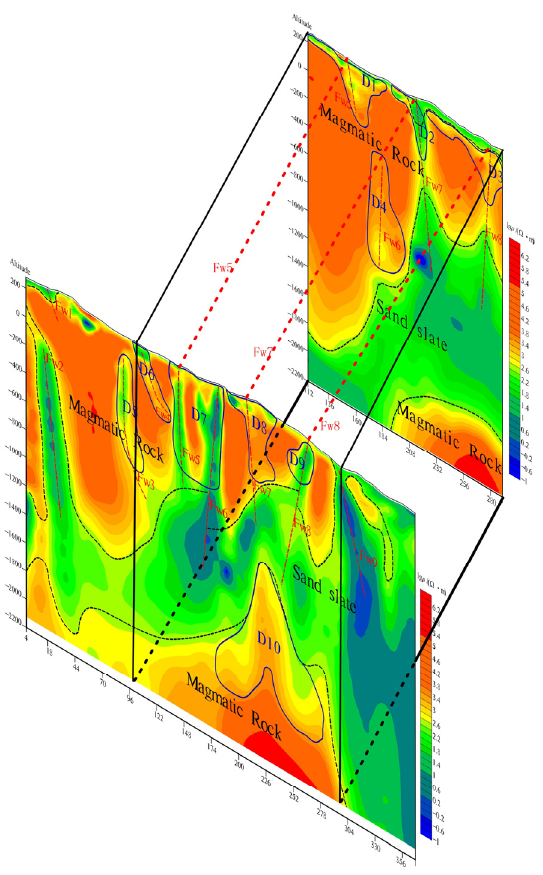
Figure 6. Comparison diagram of AMT comprehensive profile.